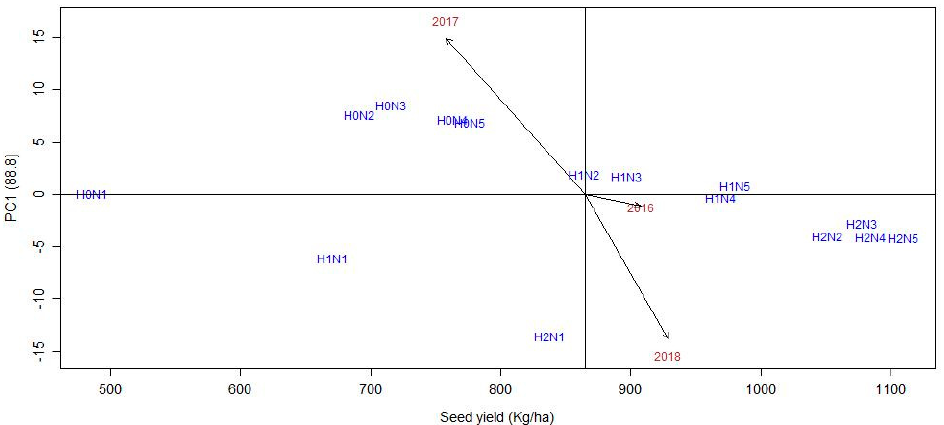
Figure 1. AMMI analysis biplots of (a) first interaction principal component axis (IPCA1) vs. seed yield (SY).